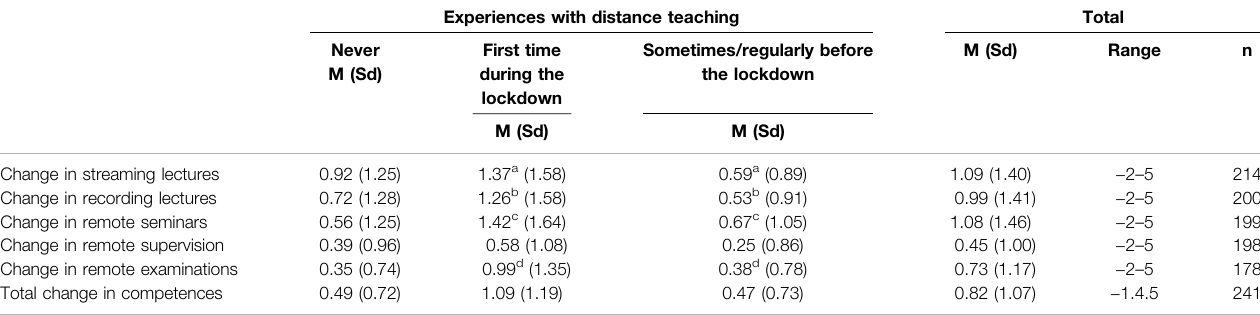
TABLE 4 | Means and standard deviations of the changes in competence variables.